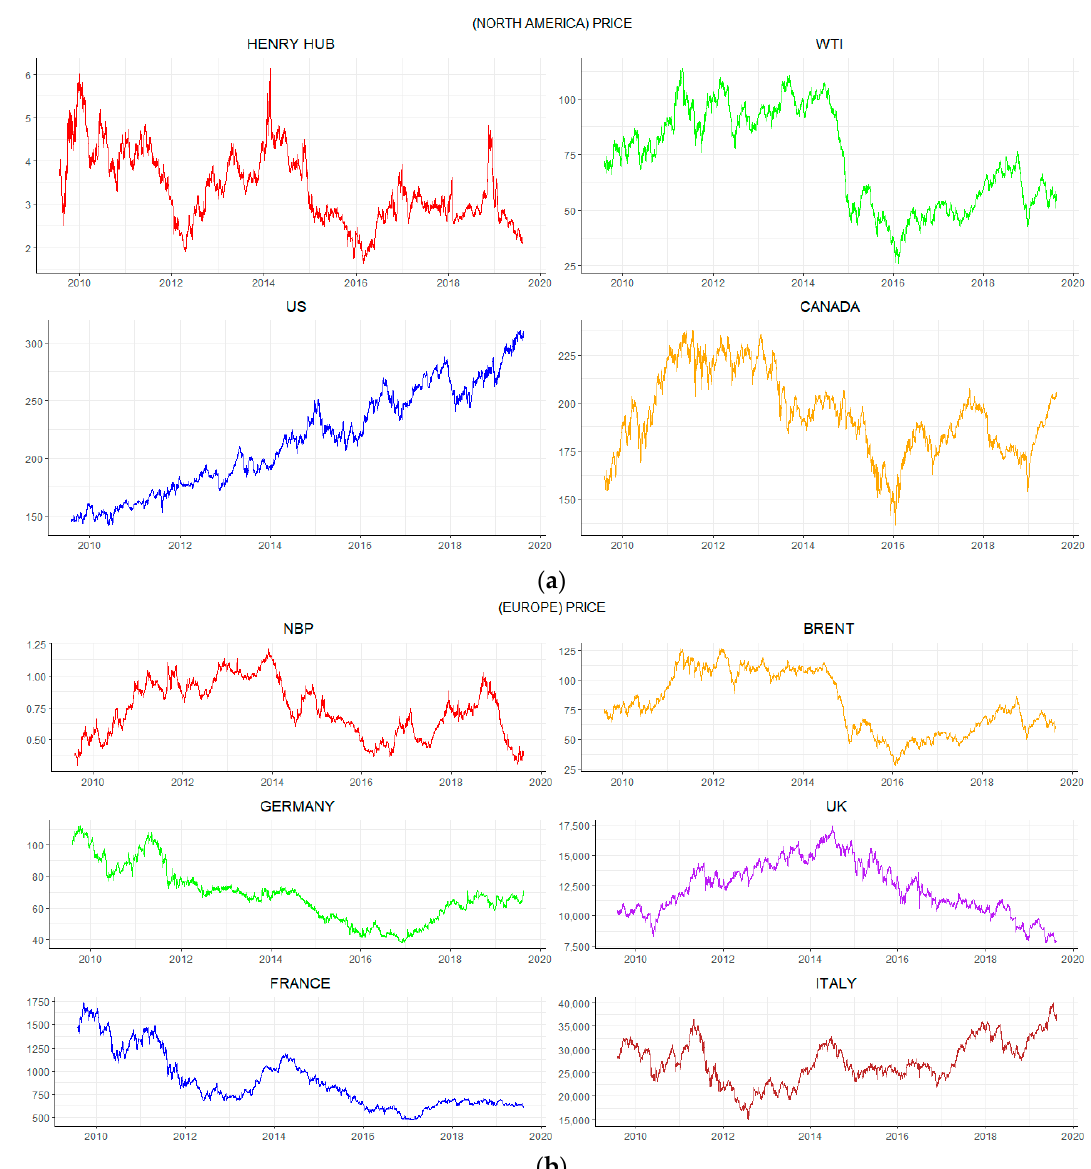
Figure 1. ( a ) Time-variations of the price series in North America. Notes: Henry Hub indicates natural gas; WTI indicates crude oil; US indicates the S&P 500 Utilities Index; CANADA indicates the S&P/TSX Capped Utilities Sector Index. ( b ) Time-variations of the price series in Europe. Notes: NBP indicates natural gas; BRENT indicates crude oil; GERMANY indicates the DAX subsector for all electricity; UK indicates the FTSE 350 Electricity Index; FRANCE indicates the CAC Utilities Index; ITALY indicates FTSE Italia All-Share Utilities Index.